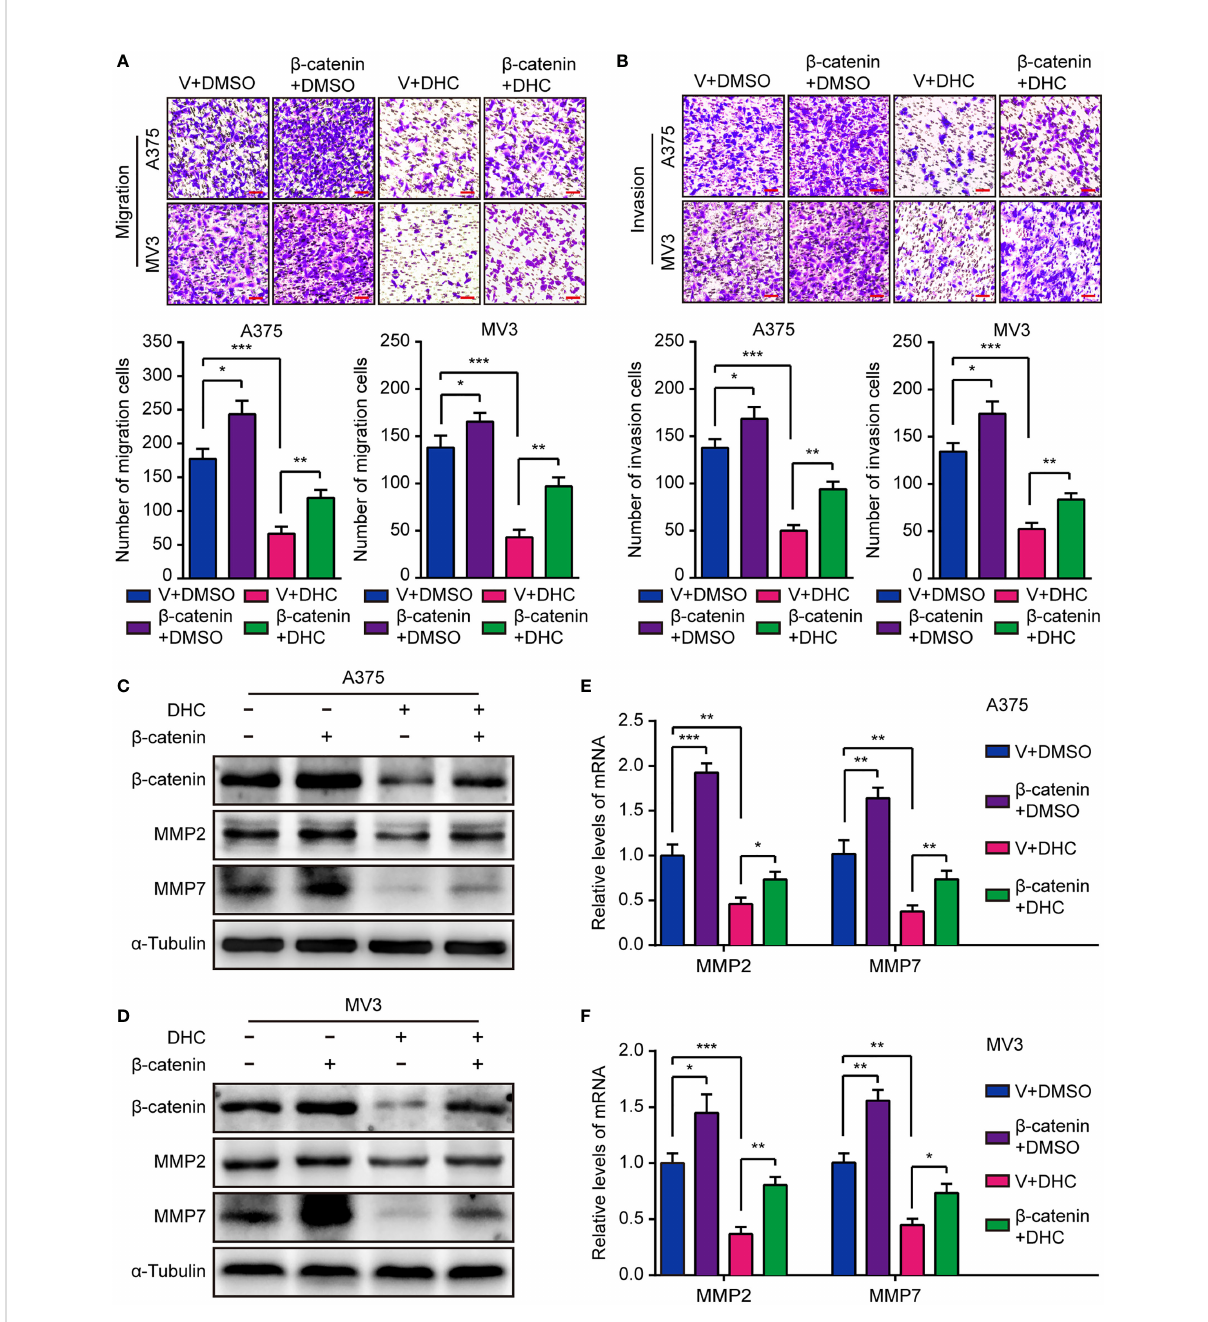
FIGURE 5 Overexpression of b -catenin retrieves DHC-induced cell migration and invasion inhibition. (A, B) Migration and invasion transwell assays were performed in b -catenin/vector overexpressed A375 and MV3 cells treated with 100 m M DHC. Scale bar, 100 m m. (C, D) The protein expression of b - catenin, MMP2 and MMP7 in b -catenin/vector overexpressed A375 and MV3 cells treated with 100 m M DHC for 48 h. (E, F) The mRNA expression of MMP2 and MMP7 in b -catenin/vector overexpressed A375 and MV3 cells treated with 100 m M DHC for 48 h. * P <0.05; ** P <0.01; *** P <